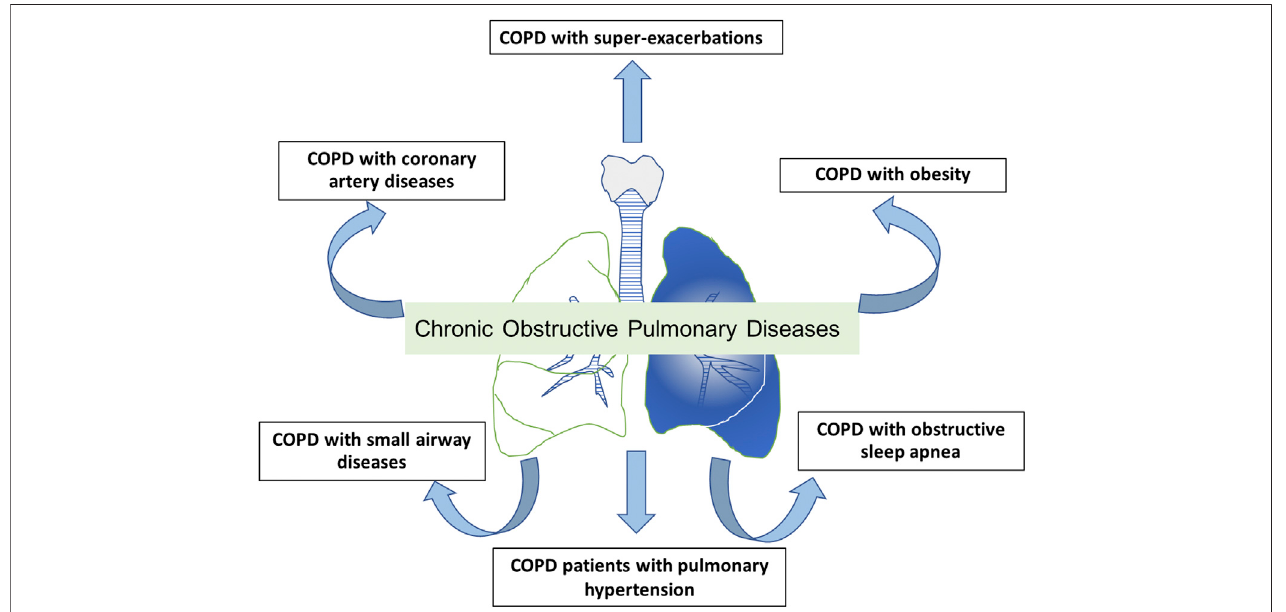
FIGURE3| The potential roleand positionsofro fl umilast forbeing maintenancetherapy inpatientswithasthma-COPD overlap (ACO).ICS: inhaled corticosteroid; LAMA: long-acting muscarinic antagonist; LABA: long-acting β 2 agonist.